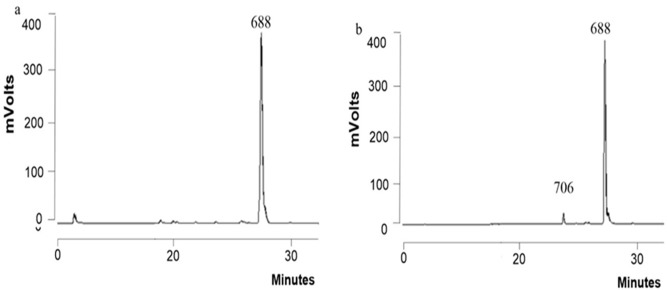
Purification of LSL produced by S. bombicola.HPLC-ELSD and LC-MS analysis of the LSL precipitate from the bioreactor. (a) The MW 688 g/mol corresponds to diacetyl C18:1 LSL. (b) HPLC-ELSD analysis following purification of the LSL precipitate. The MW 706 g/mol = diacetyl C18:1 ASL, which is the result of minor hydrolysis of the MW 688 compound.